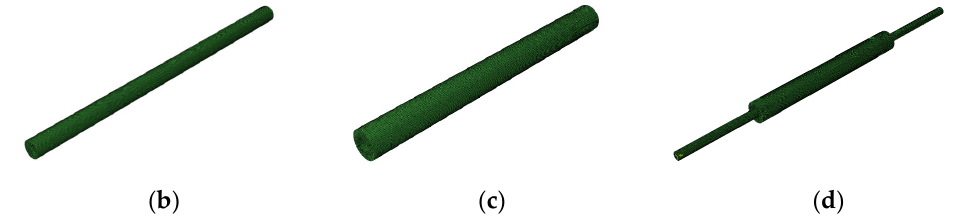
Figure 6. Diagrams of model meshes. ( a ) Sleeve. ( b ) Reinforcement. ( c ) Grouting material. ( d ) Specimen GS16-8d.